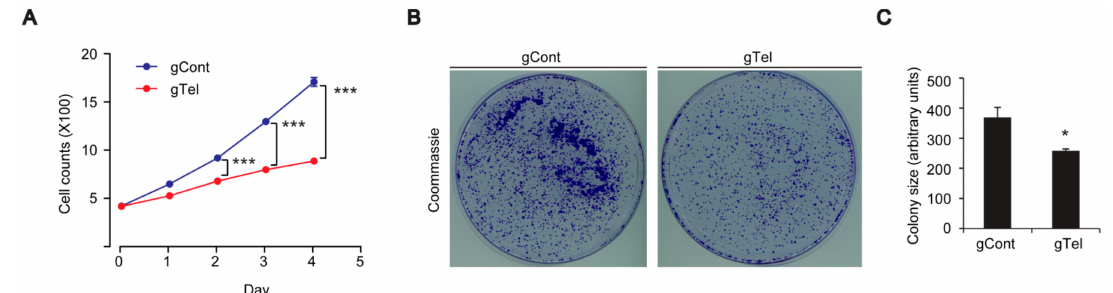
Figure 2. Limited replicative potential of SH-SY5Y cells with telomere removal by CRISPR-Cas9. ( A ) Cell growth assay for SH-SY5Y cells transfected with gTel or gCont and determined by trypan blue cell counting at the indicated days ( n = 7 per group); ( B ) Representative image of SH-SY5Y cells stained with coomassie blue from colony formation assay; ( C ) Quantification of average colony size for coomassie stained SH-SY5Y cell colonies per each group ( n = 3 plates per group). Quantified data are expressed as mean ± SEM. Statistical significance was determined by unpaired two-tailed Student’s t test or ANOVA test with Tukey post-hoc analysis, * p < 0.05, and *** p <